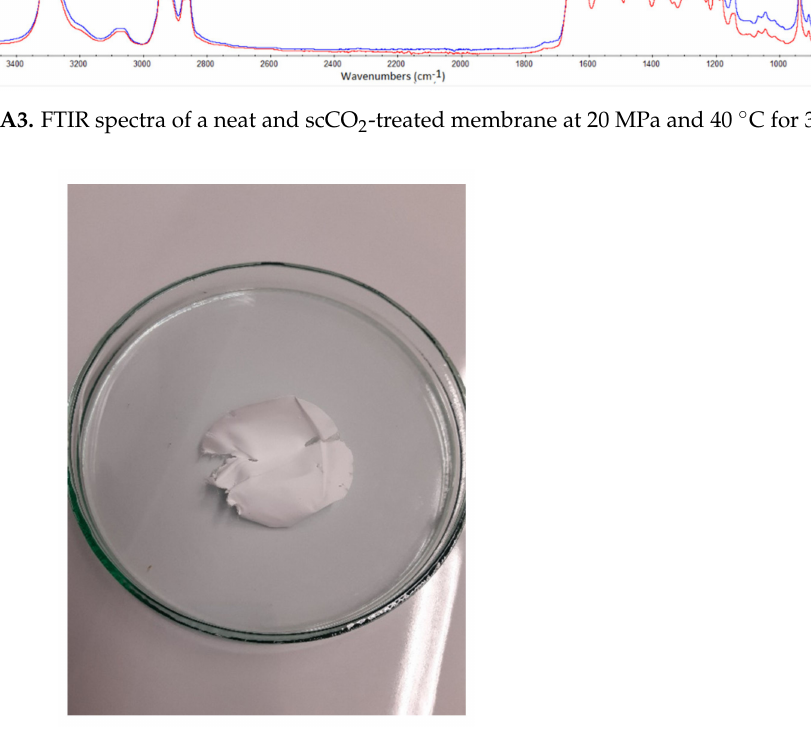
Figure A4. The appearance of the polyamide membrane with 54% carvacrol. The membrane was purposely bent during the SSI and could not be unfolded without